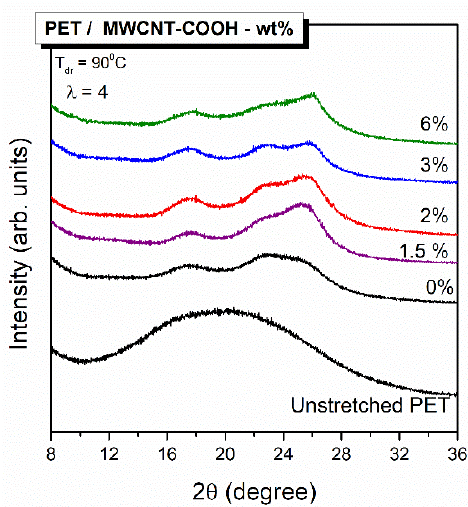
Figure 6. XRD profiles of neat PET and PET / MWCNT composites films uniaxial stretched to draw ratio λ = 4. The XRD pattern of an unstretched PET film is depicted at the bottom for comparison.